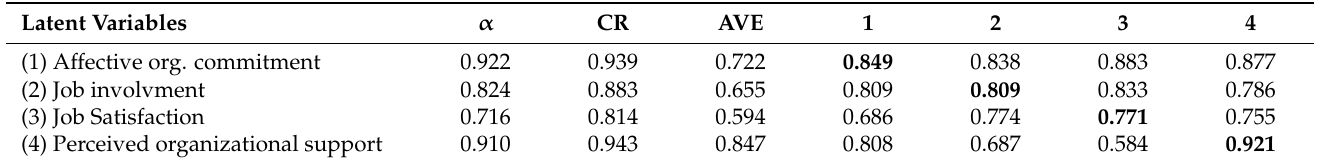
Table 1. Composite reliability, average variance extracted, correlations, and discriminant validity checks.